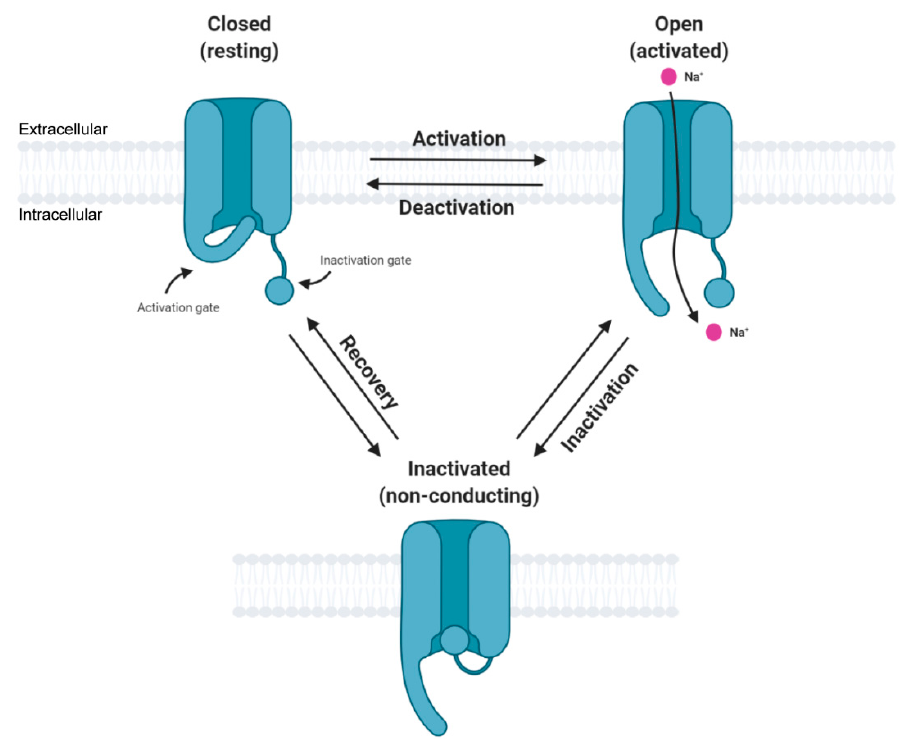
Figure 2. Simplified state transition model of voltage-gated sodium channels featuring closed, open, and inactivated states. This figure was created with BioRender.com.